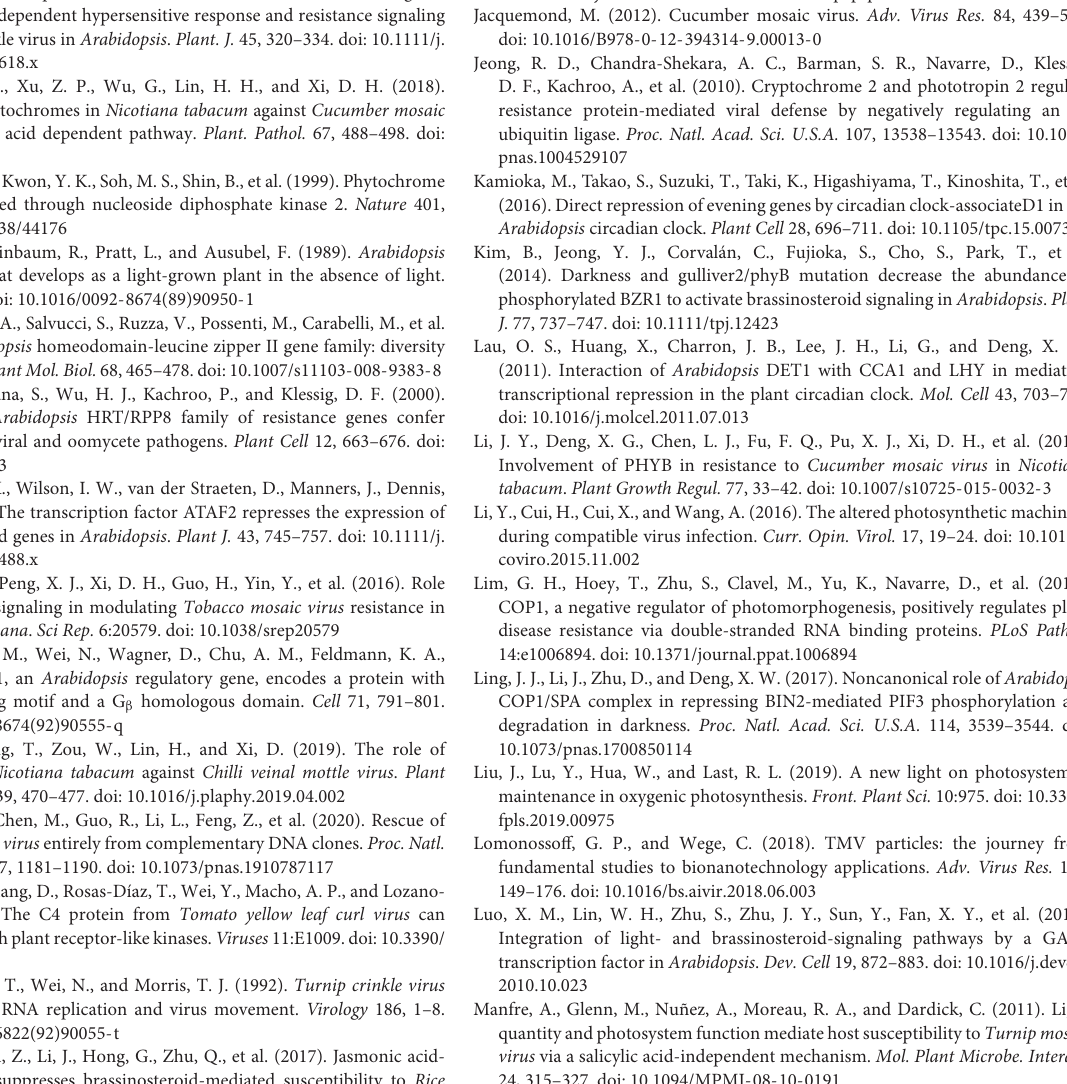
tabacum . Plant Growth Regul. 77, 33–42. doi: 10.1007/s10725-015-0032-3